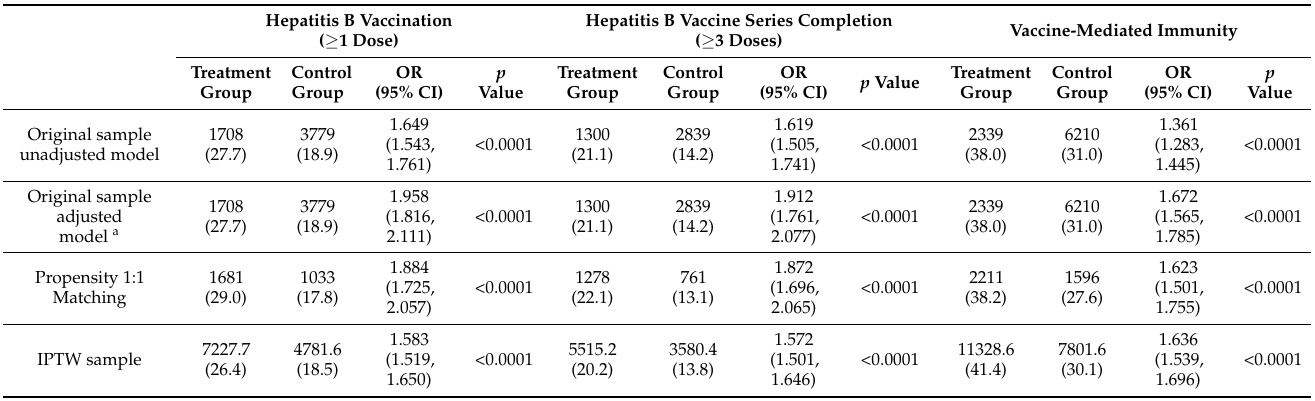
Table 1. Characteristic of total sample, original sample, propensity score-matched sample, and in- verse probability of treatment-weighted sample.